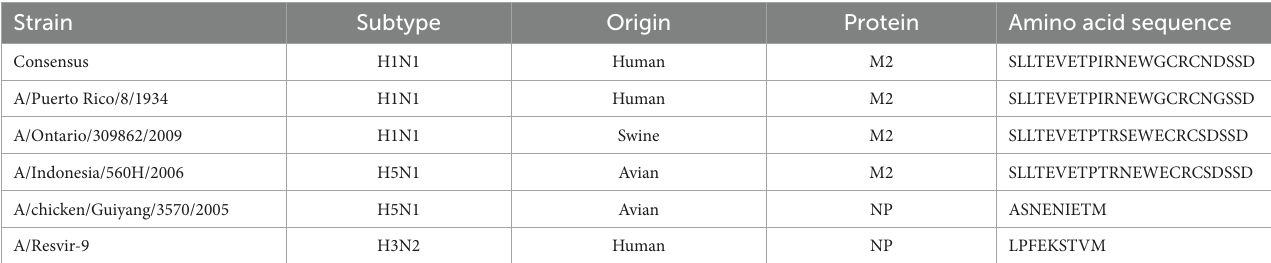
TABLE 1 Amino acid sequences of influenza A virus